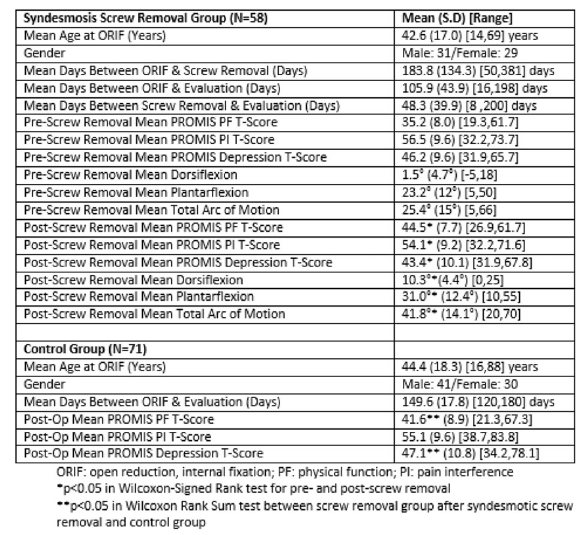
Table 1 (abstract P6). Demographic and PROMIS Data for Patients Undergoing Ankle Open Reduction and Internal Fixation (ORIF) with Syndesmotic